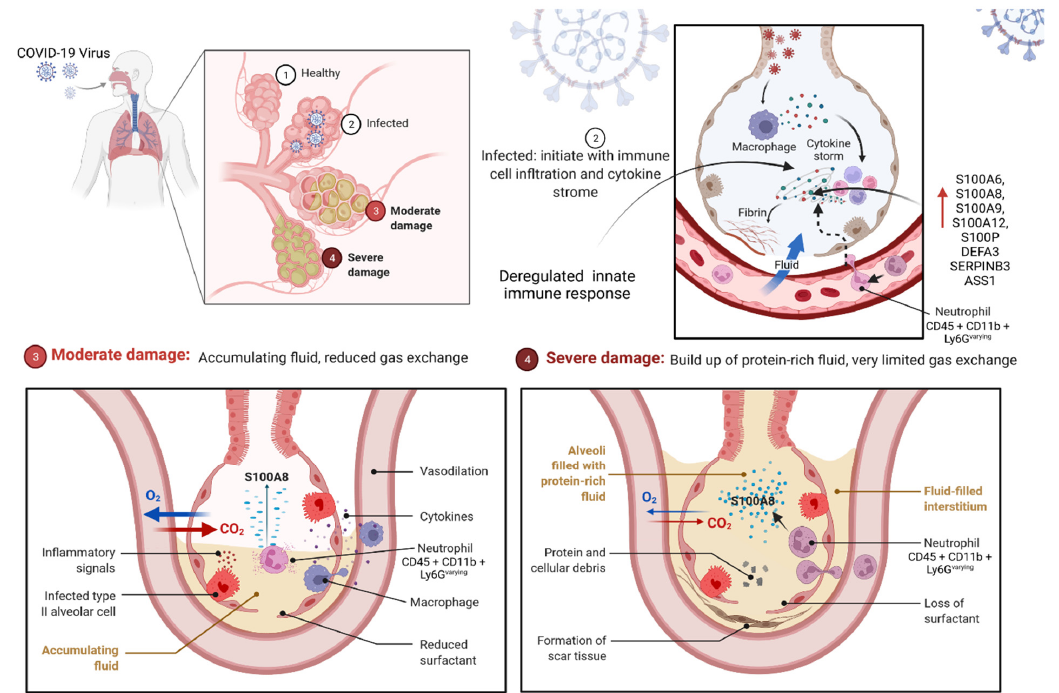
Figure 5. This diagram depicts the progression of a COVID-19 infection from the healthy to fatal stage. COVID-19 disrupts the immune response by inducing a cytokine storm and S100A8 overexpression. Infection with COVID-19 induces the formation of abnormal neutrophils with variable CD45 + CD11b + Ly6G markers, causing these cells to behave abnormally. Created with BioRender.com.